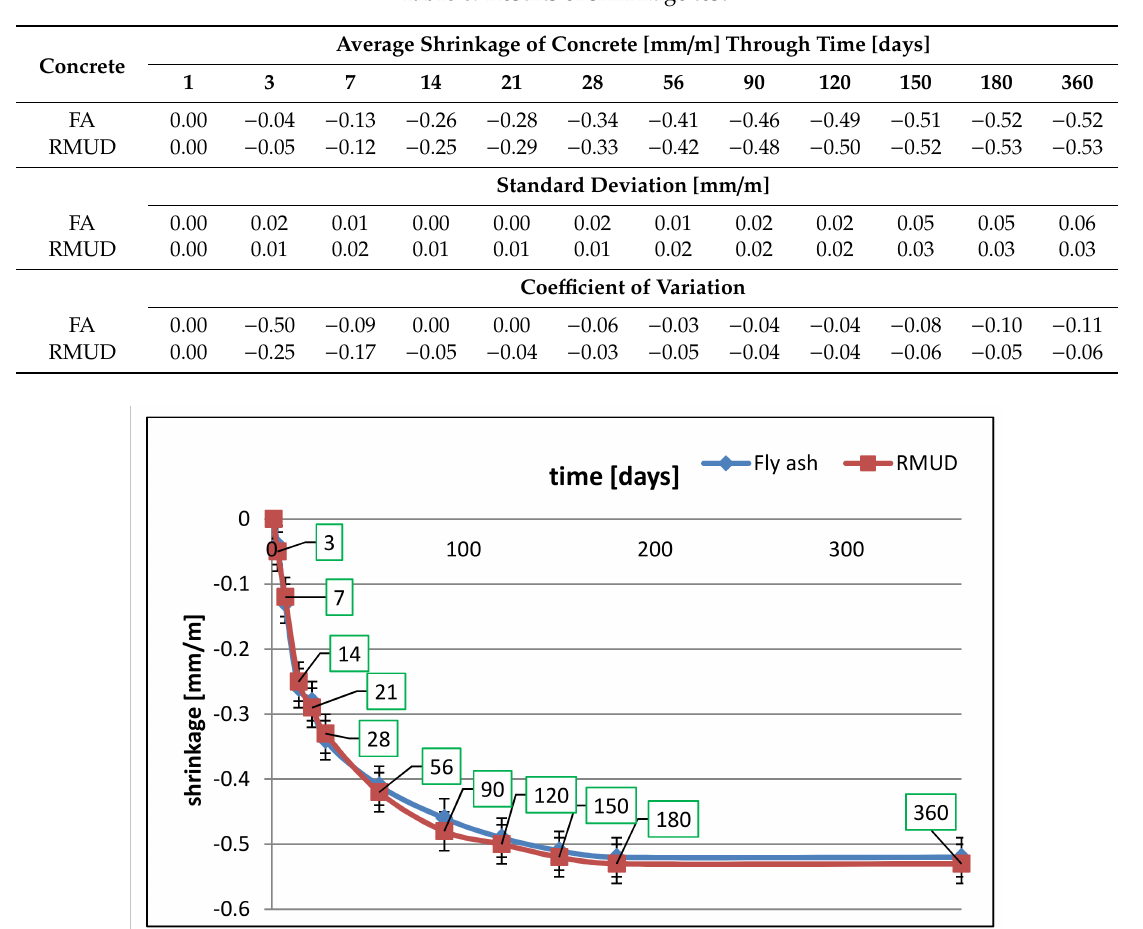
Figure 9. Results of shrinkage